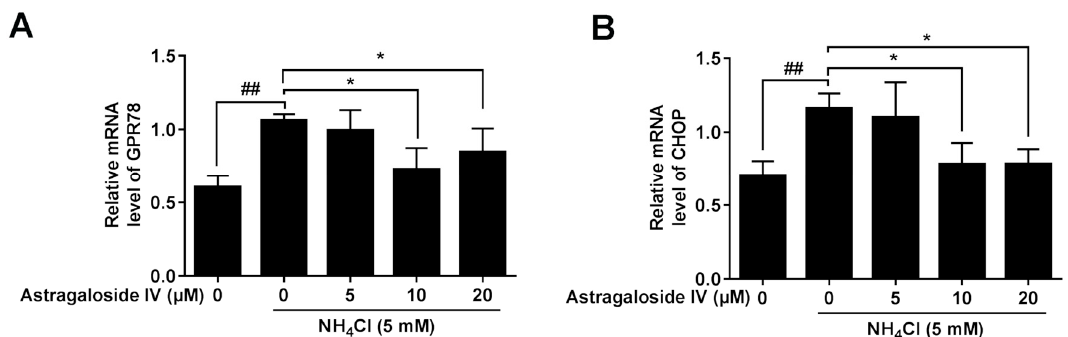
Figure 5. The protective effects of astragaloside IV on the mRNA expression of endoplasmic reticulum (ER) stress markers (CHOP and GPR78) induced by ammonia in MAC-T cells. The mRNA expressions of the endoplasmic reticulum stress markers GRP78 ( A ) and CHOP ( B ) were analyzed using quantitative real-time PCR. Data are shown as mean ± SD. n = 4. *, p < 0.05; ## indicates a significant difference from untreated cells p < 0.01.